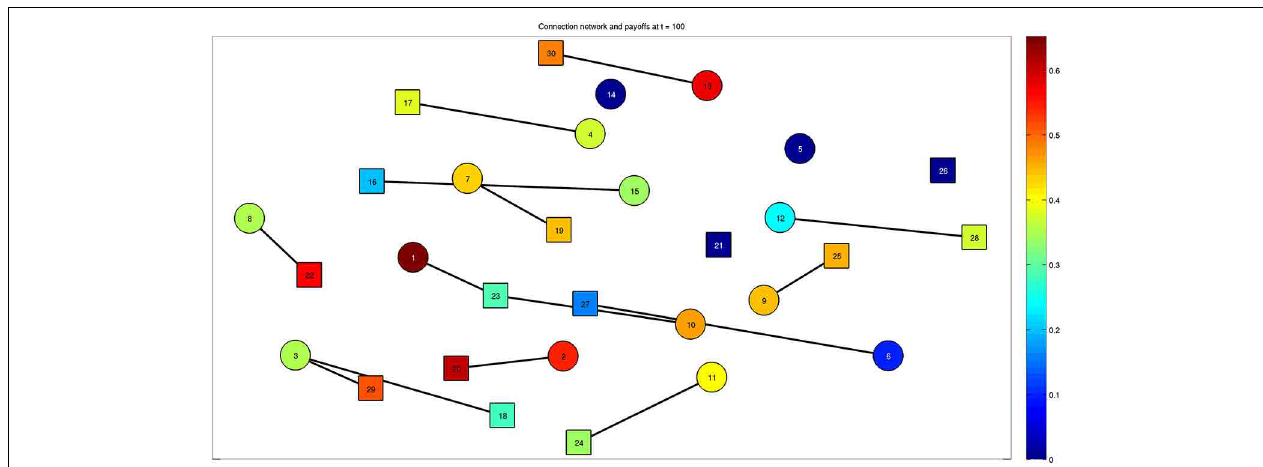
FIGURE 5 | Final configuration of the network composed of 30 bacteria at steady state ( t = 100). Bacteria belonging to the two classes are represented by different shapes, such as squares and circles. The color associated to each bacterium represents the effective quantity of energy it